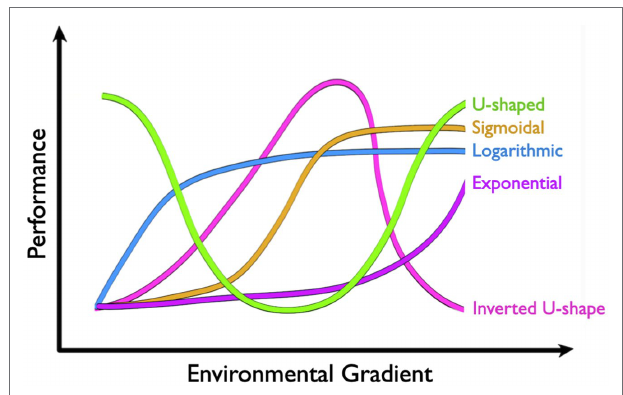
FIGURE 2 | Common shapes of physiological performance curves include U-shape, sigmoidal, logarithmic, exponential, and inverted